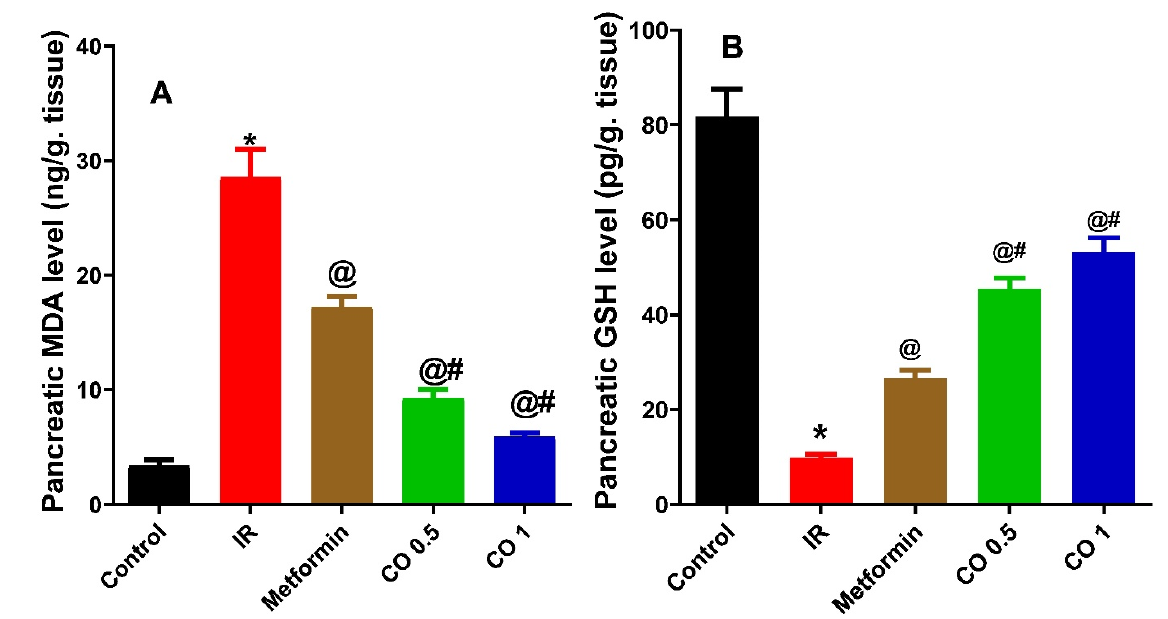
Figure 6. Effect of coriander oil (CO, 0.5 and 1 mL/kg, PO) and metformin (50 mg/kg/day, PO) on pancreatic malondialdehyde (MDA) ( A ) pancreatic reduced glutathione (GSH) ( B ) dexamethasone- induced insulin resistance in rats (IR). Results were analyzed by one-way ANOVA followed by the post-hoc Tukey test. Results are shown in mean ± SEM ( n = 6). * , @, # p < 0.05 compared to normal, IR, and metformin groups, respectively.